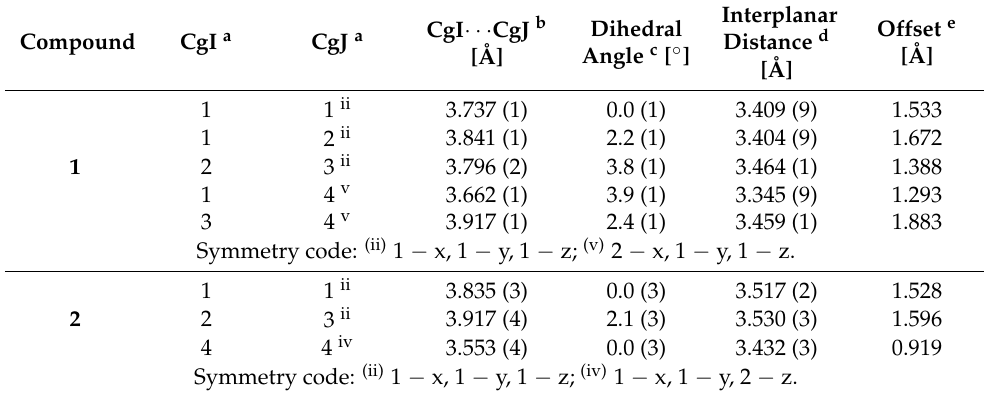
Table 4. π – π interactions geometry for compounds 1 and 2 .